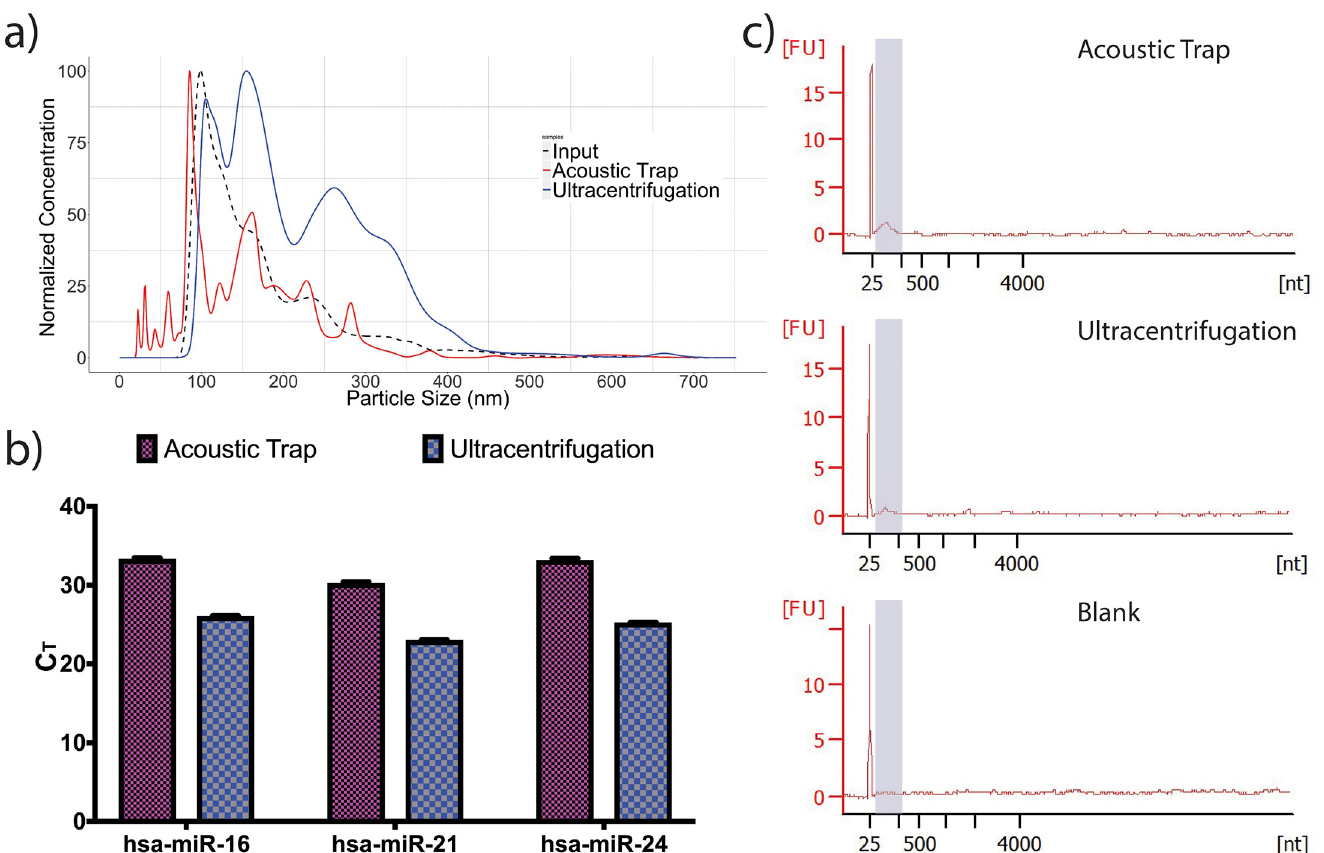
Fig 2. Characteristics of acoustic trap and ultracentrifugation enriched EVs and the associated RNA products after total RNA isolation. a) Representative nanoparticle tracking analysis of EVs obtained after acoustic trap (red solid line) or ultracentrifugation enrichment (blue solid line) compared to diluted input sample (dashed black line). Acoustic trap, ultracentrifugation and input EVs showed mean ( ± SD) Dv50 of 149 ( ± 14), 198 ( ± 8) and 143 ( ± 4) nm respectively. b) Verification of intact miRNA after RNase A treatment such as hsa-miR-16/21/24 by qRT-PCR from acoustic trap and ultracentrifugation of urine prior to library construction. Note the different volume of urine aliquoted for acoustic trapping, 9.75 mL and ultracentrifugation, 72 mL. The RNA concentration of acoustic trap sample was estimated by multiplying the fold change (acoustic trap to ultracentrifugation sample) of miR-16/21/24 to the RNA concentration of ultracentrifugation sample determined by Qubit assay. c) The size profile of the isolated total RNA are predominantly small RNAs less than 500 nt and devoid of any intact rRNA or mRNA.